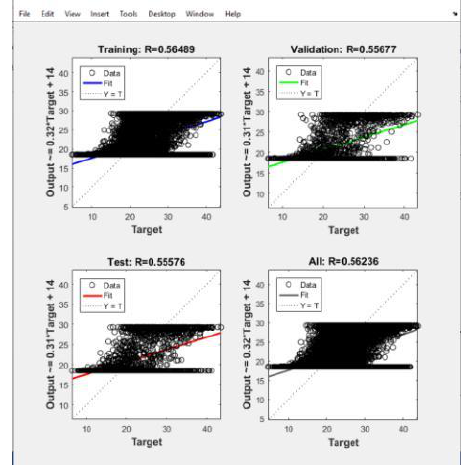
Figure 27 . The three plots represent the training, validation, and testing data. The dashed line in each plot represents the perfect result – outputs = targets. The solid line represents the best fit linear regression line between outputs and targets. The R value is an indication of the relationship between the outputs and targets. If R = 1, this indicates that there is an exact linear relationship between outputs and targets. If R is close to zero, then there is no linear relationship between outputs and